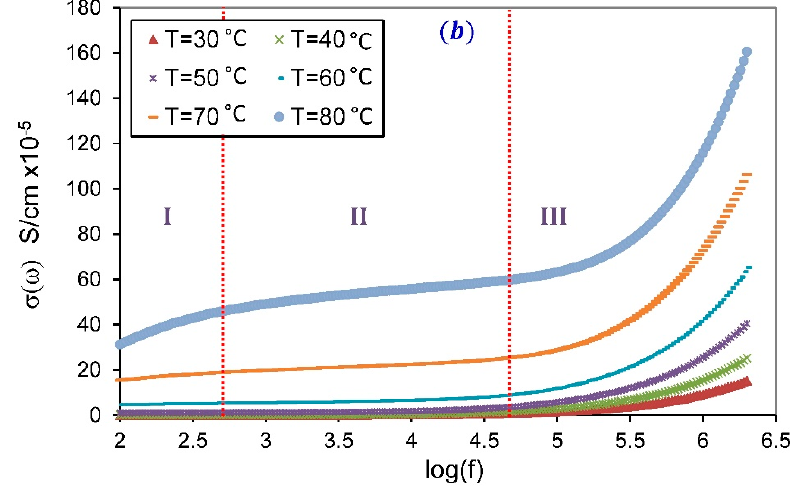
Figure 5. Conductivity versus log(f) for ( a ) pure PVA, ( b ) SPE-30, at different temperatures.